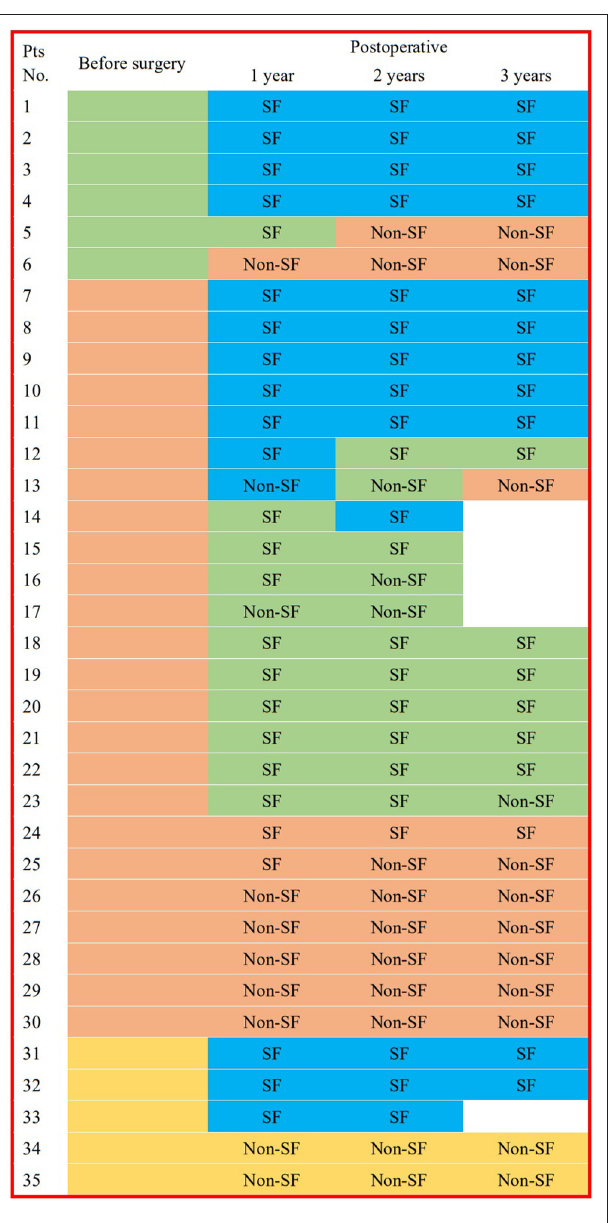
FIGURE 3 | IID patterns on scalp EEGs in different times for each patient. This figure shows the interictal epileptiform discharge (IID) patterns from 3 years before the surgery to 3 years after surgery in every patient. Blue box for EEG without IID; green box for focal IIDs; orange box for multiple focal IIDs, and golden box for generalized IIDs. pts, patients; pre-op, pre-operative; post-operative, post-operative; SF, seizure freedom.